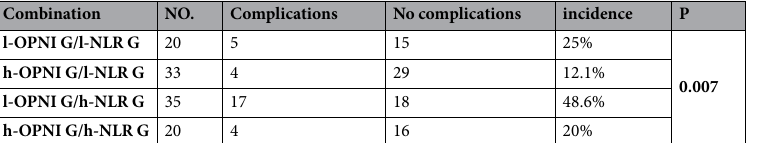
Table 10. Incidence of postoperative complications by combination of OPNI and NLR. h-OPNI G , high OPNI group; l-OPNI G , low OPNI group; h-NLR G , high NLR group; l-NLR G , low NLR